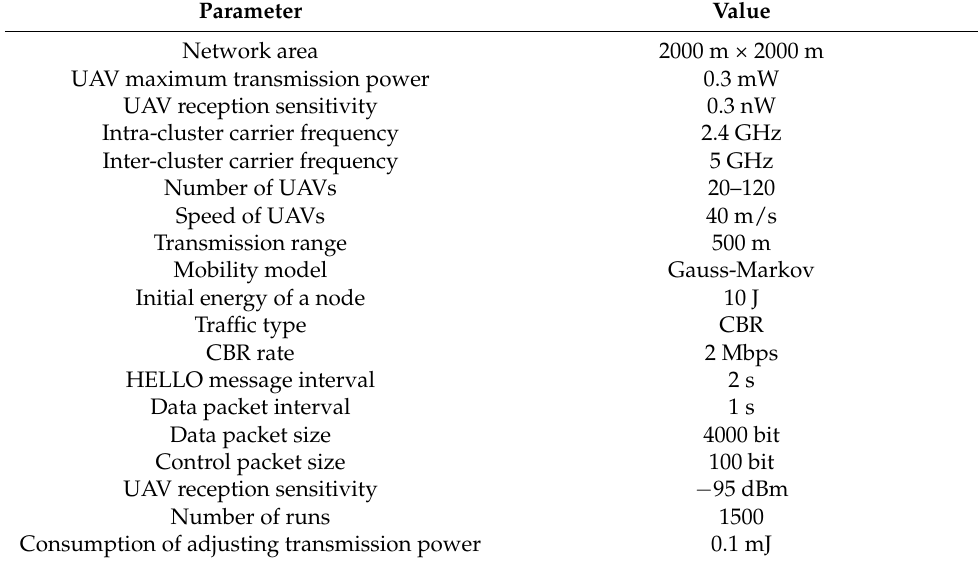
Table 4. Simulation parameters.